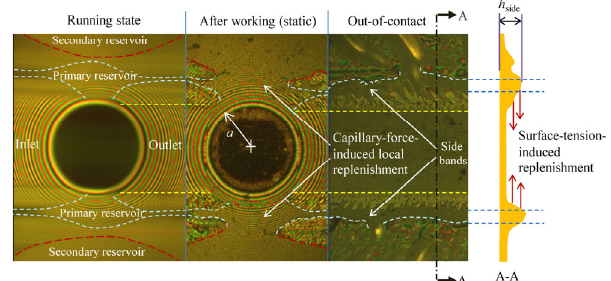
Fig. 12 Equilibrium film and replenishment mechanisms, Grease A, u e = 128 mm/s.